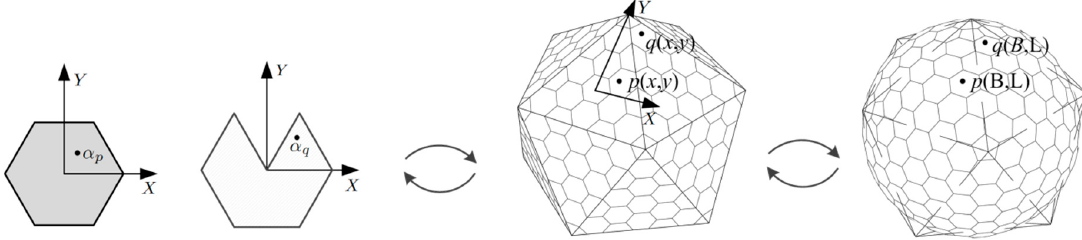
Figure 11. Diagram of conversion between indices and geographical coordinates (source—own study).